Question: Is the quantity shown trending increasing or decreasing?
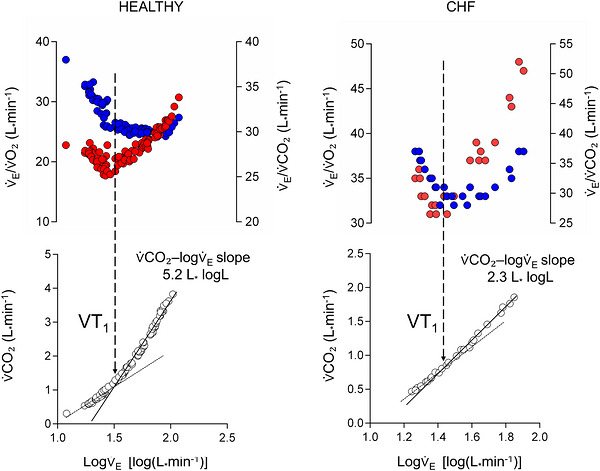
Answer: increasing